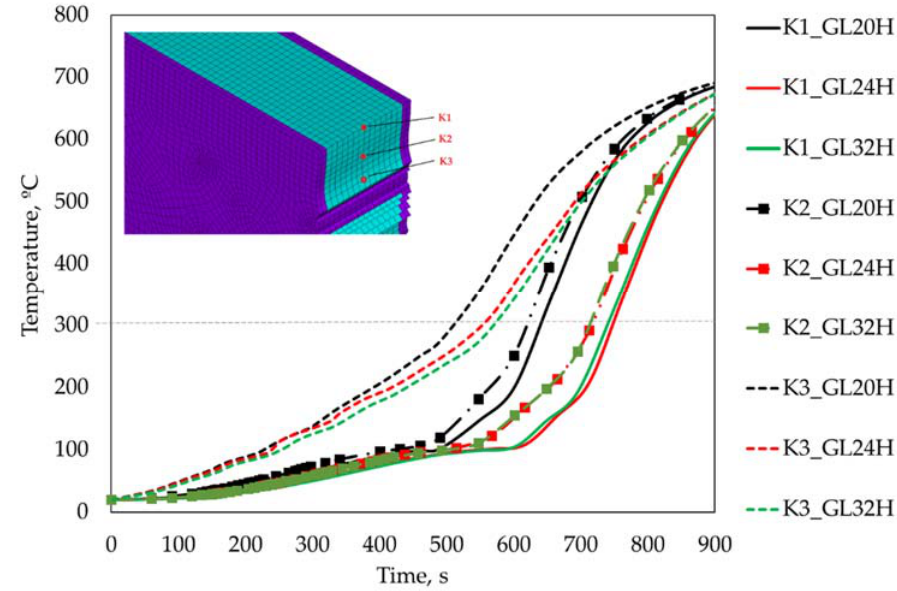
Figure 18. Temperature–time history on the connection.